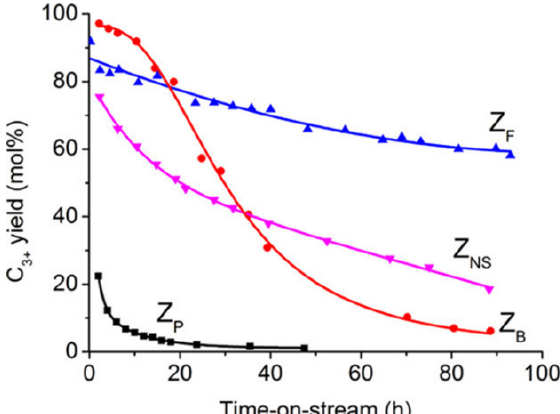
Figure 11. Catalytic activity of ethanol conversion over the parent ZSM-5 zeolite (Z p ), NH 4 F etched ZSM-5 zeolite (Z F ), desilicated ZSM-5 zeolite (Z B ), and ZSM-5 nanosheet (Z NS ). Reprinted with permission from [45]. Copyright 2019 American Chemical Society.